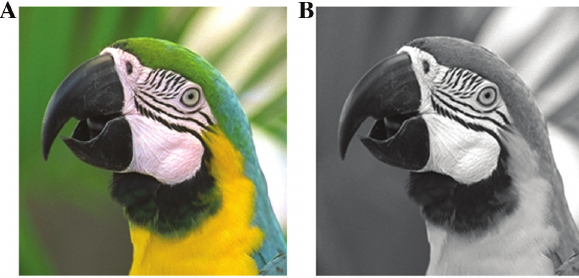
Figure 2: Example Images for LR-SVM Testing.